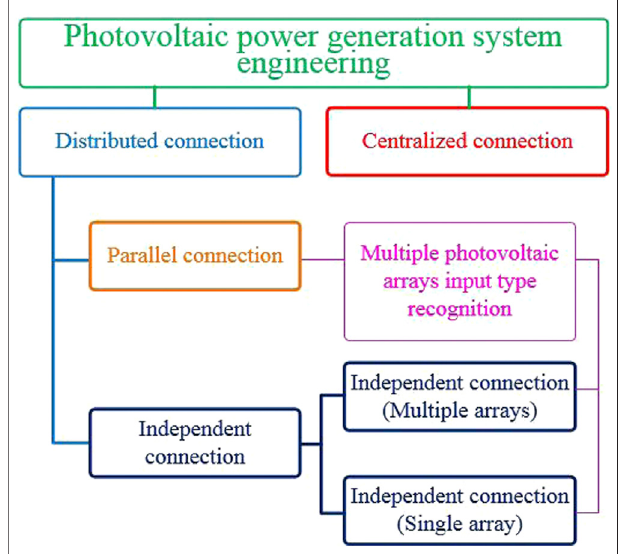
FIGURE 2 | PV string connection types.